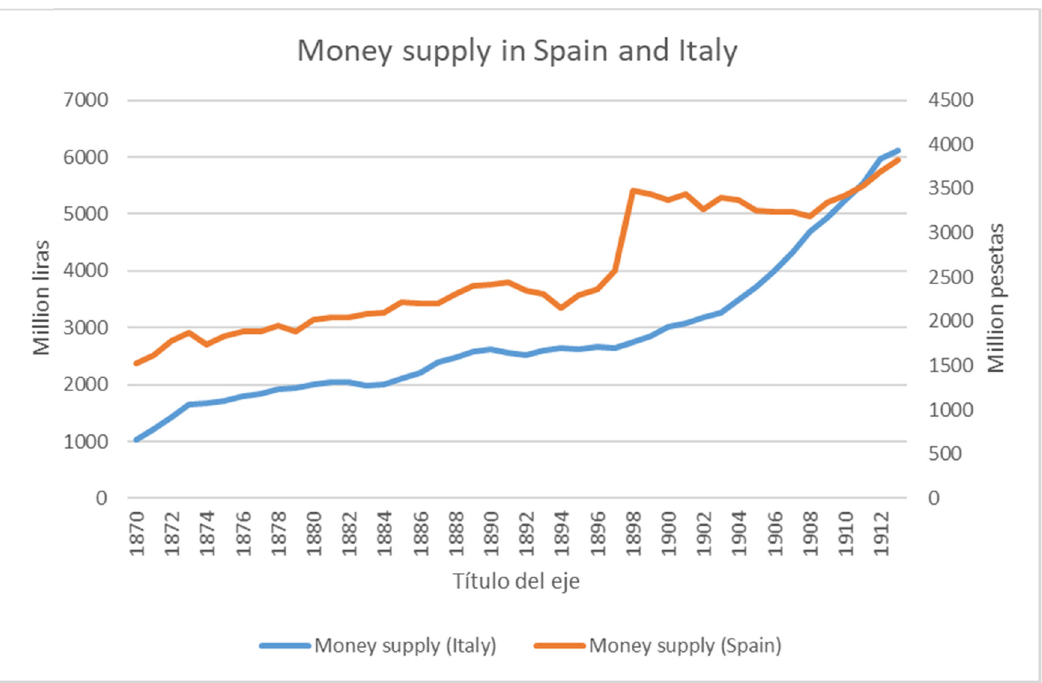
Figure 3: Money supply in Spain and Italy. Martín Aceña ( 2017 ) for Spain and by Barbiellini, De Bonis, Rocchelli, Salvio, and Stacchini ( 2016 ) for